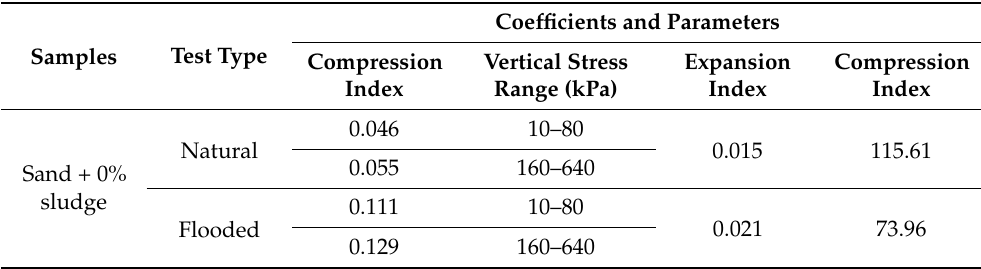
Table 5. Coefficients and parameters of the double oedometer tests with soil samples and soil–sludge mixtures with a dry specific weight of 15.0 kN/m 3